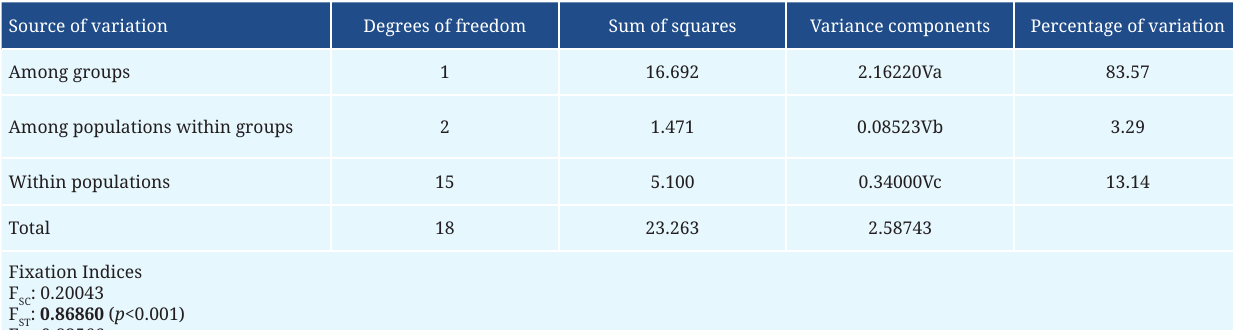
TABLE 3 | Analysis of molecular variance (AMOVA) from the populations of Parodon nasus . Two groups were considerate: Cuiabá River; Mogi-Guaçu River + Passa Cinco River + Paiol Grande